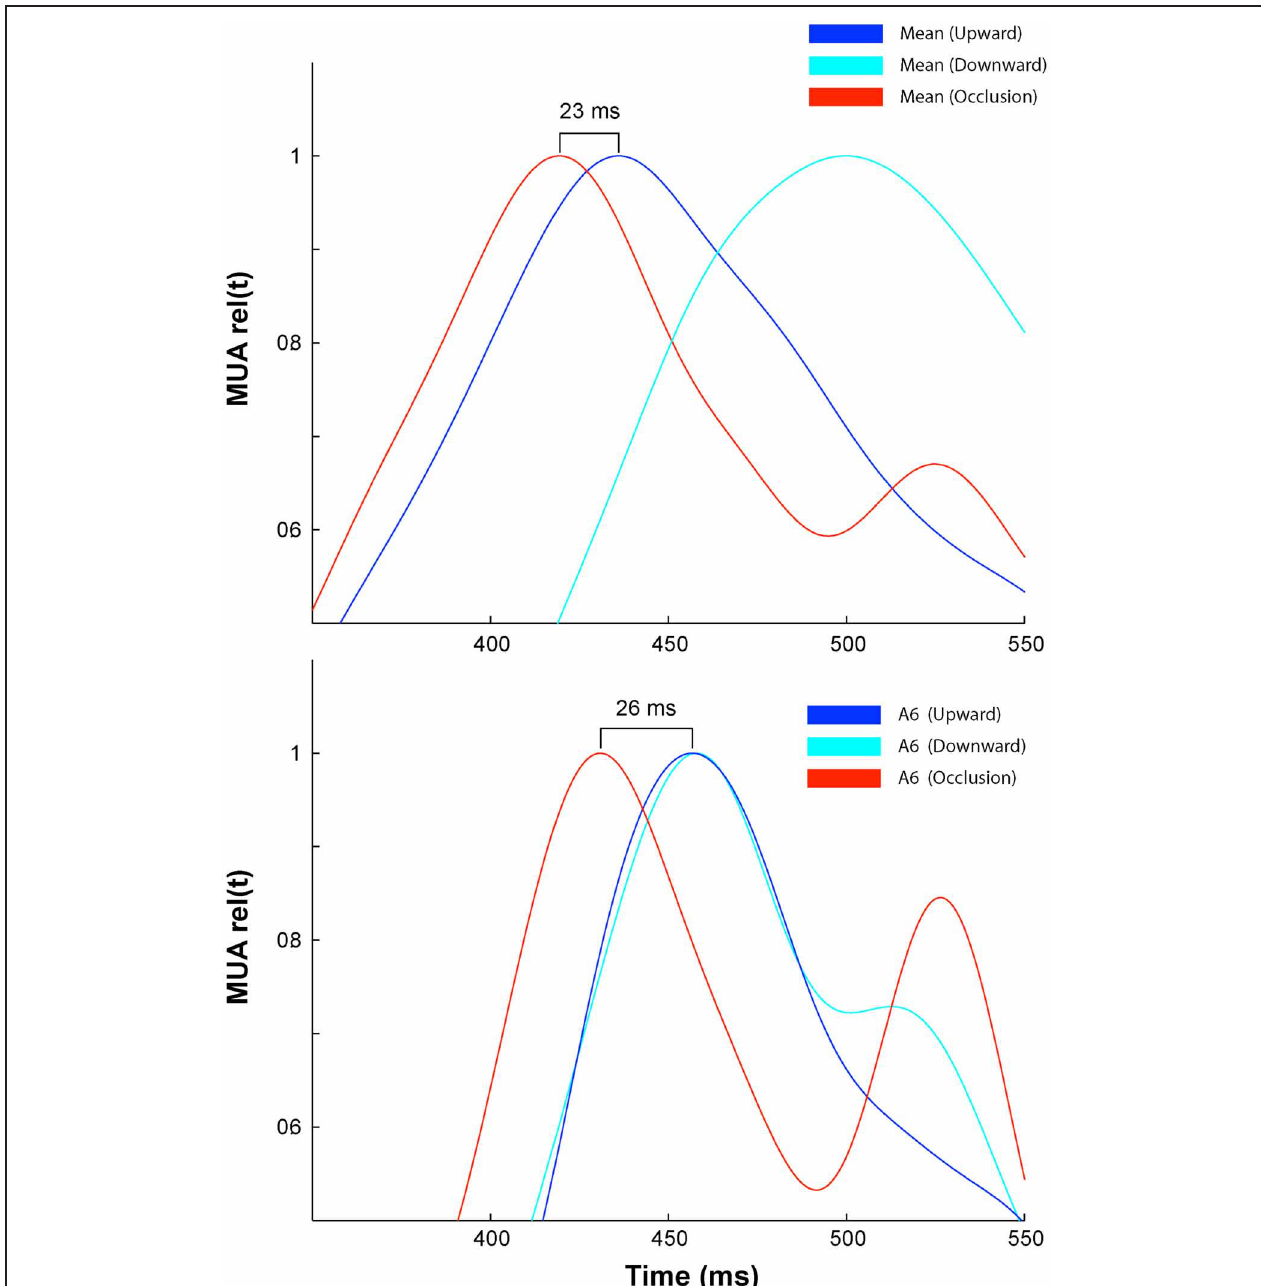
FIGURE A2 | Comparisonof the mean, ( N = 10 Animals), MUA to that obtained from a single animal, (A6) that showed identical peak times in response to upward and downward moving bars at the cortical site representing the central field of view. Note that in both cases the